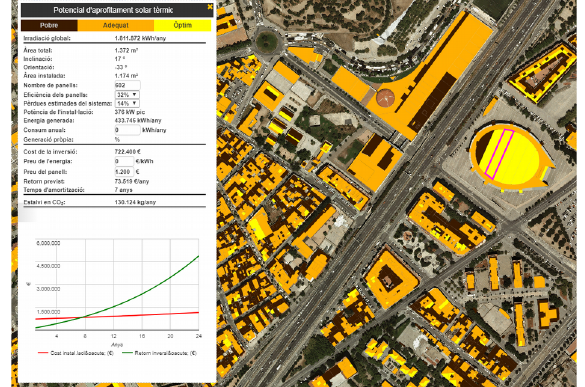
Figure 9. Suitability index for the deployment of solar thermal energy facilities 3.6 Urban Green